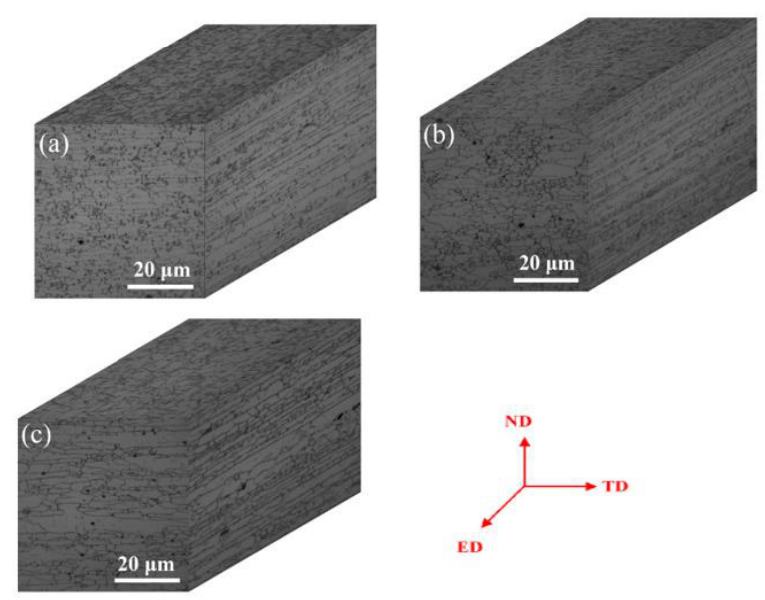
Figure 1. Three-dimensional view of microstructures of alloys with different Zn/Mg ratios: ( a ) 1# alloy; ( b ) 2# alloy; ( c ) 3# alloy. EBSD maps from cross sections (ND – TD) of alloys with different Zn/Mg ratio are shown in Figure 2. The distribution of grain orientation, distribution of grain boundary angle and recrystallization microstructures are also presented in Figure 2. In Figure 2a – c, the white solid line represents the small angle grain boundary (2° < θ < 15°) and the black solid line represents the large- angle grain boundary (θ > 15°) and the average grain size of the alloys with different Zn/Mg ratio is about 3 – 4 μm. There was no significant effect on the grain size of alloys with different Zn/Mg ratios. The distribution of corresponding angular in grain boundary is shown in Figure 2d – f. When the Zn/Mg ratio was 11.4, 8.1 and 6.1, the corresponding large-angle grain boundary ratio would be 68.1%, 61.0% and 54.1%, respectively. The proportion of grain boundary with large angle gradually decreased with the decrease of the Zn/Mg ratio. However, the misorientation distribution of the grain boundary angle had a distinguished behavior. The frequency of low- and high-angle grain boundaries increased as the Zn/Mg ratio decreased, especially the angles between 30 – 50° decreased significantly. The alloy with a Zn/Mg ratio of 6.1, showed the lowest number of grains randomly distributed due to the insufficient recrystallization occurred in this alloy. Results in Figure 2g – i indicate that when the Zn/Mg ratio was 11.4, 8.1 and 6.1, the proportion of recrystallization fraction would be 64.0%, 53.0% and 44.9%, respectively. With the decrease of the Zn/Mg ratio, the proportion of the recrystallization structure in the alloy gradually decreased. Therefore, as the Mg content in the alloy increased, the number of substructure grains retained after being solution heat-treated at 480 °C became more numerous. Thus, the work hardening strength will be more effective.